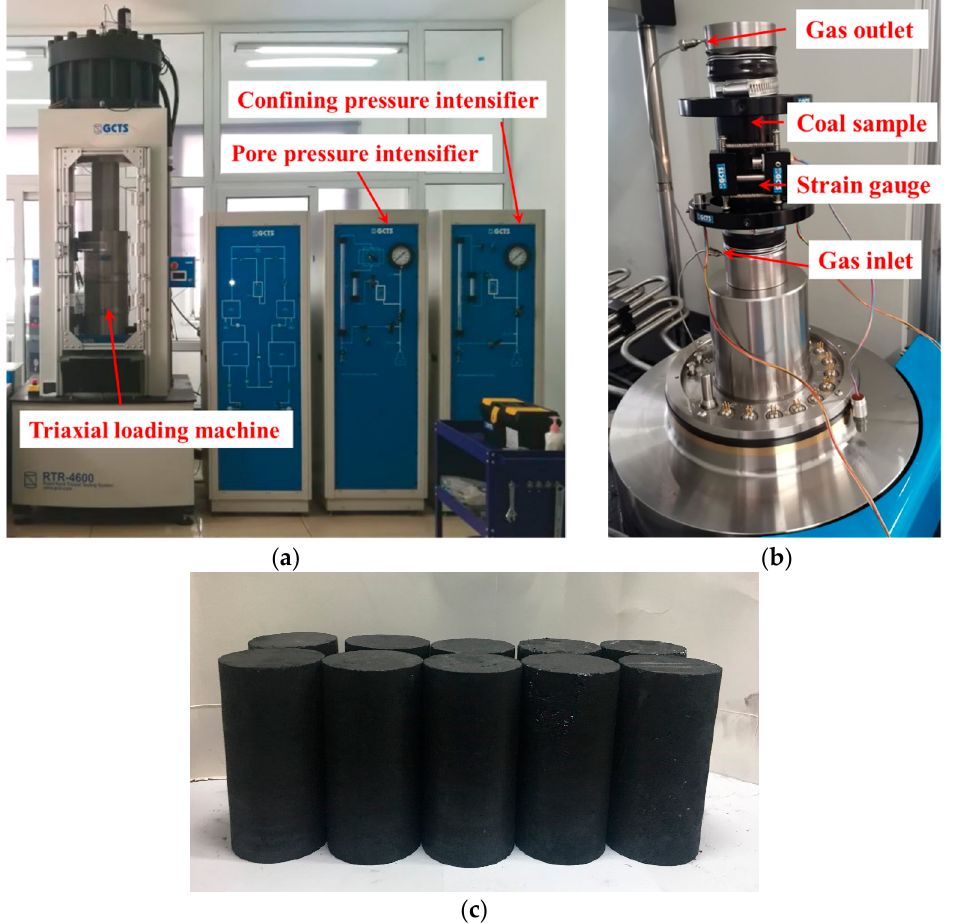
Figure 1. Diagram of experimental set-up and coal samples. ( a ) GCTS triaxial testing system, ( b ) diagram of sample installation, and ( c ) coal samples.